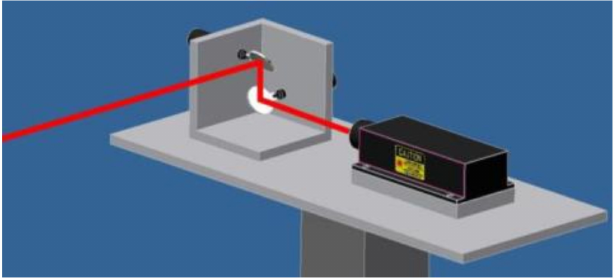
Figure 8. Illustration of 3D LiDAR using two galvanometer scanning mirrors mounted orthogonal to each other